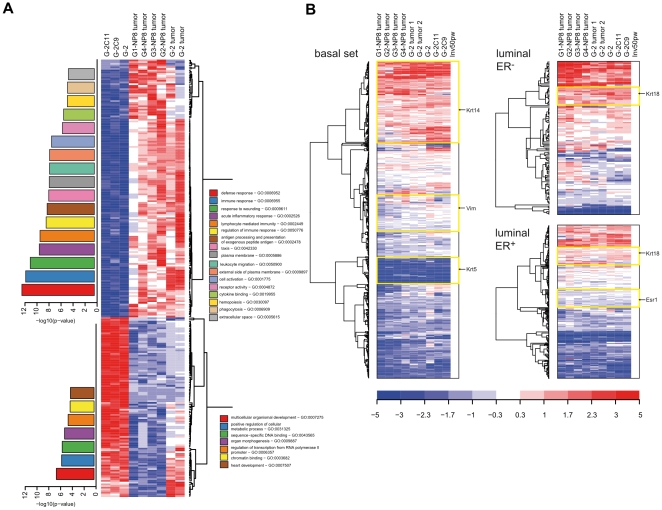
Gene expression profiling of G-2 cells and tumor samples.(A) 250 genes differentially expressed in cultured G-2 cells and endogenous WAP-T or G-2 cell derived tumors (Table S1) were used to generate a heat map. Enriched GO categories are shown as bar diagrams corresponding to higher or lower expressed gene clusters in the respective sample group. Color-coding and the height of a bar represents the statistical significance (-log10(p-value)) of the observed enrichment of the respective GO categories. (B) Genes characteristic for luminal-ER+, luminal-ER−, and basal/myoepithelial cells were used to generate heat maps. Gene expression data obtained for cell culture (G-2, G-2C9 and G-2C11 cells) and tumor samples (two G-2 transplanted tumors and four WAP-T-NP8 tumors representing four histological grades) were used for this analysis. Gene expression intensities of a mammary gland of a parous BALB/c mouse (50 days post weaning) were used as a reference. Prominent gene clusters (Krt14, Vim, Krt5, Krt18, and Esr1) are highlighted by yellow boxes. The expression values are color coded: red – high expression, blue – low expression.